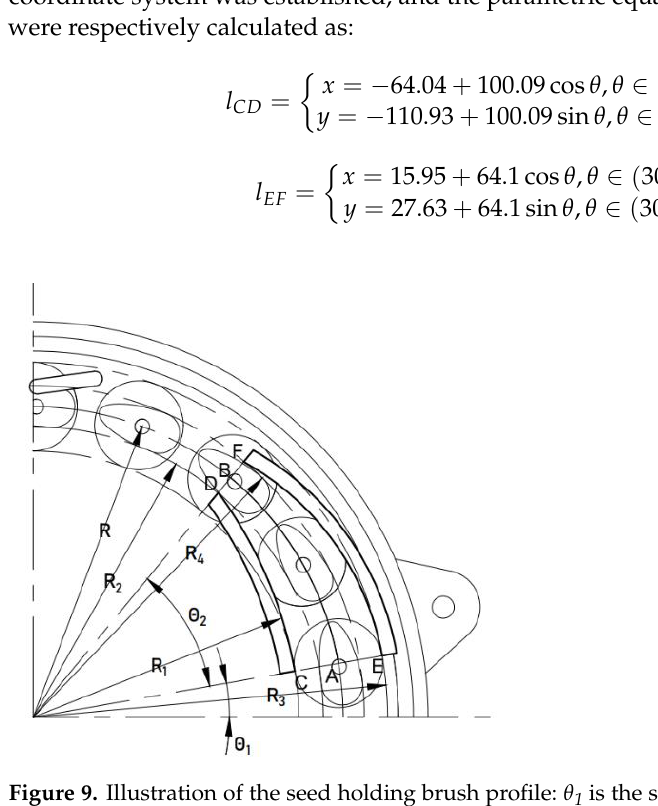
Figure 9. Illustration of the seed holding brush profile: θ 1 is the starting seed adjusting angle; θ 2 is the seed adjusting angle; R 1 is the starting circle radius of the lower seed adjusting brush; R 2 is the ending circle radius of the lower seed adjusting brush; R 3 is the starting circle radius of the upper seed adjusting brush; R 4 is the ending circle radius of the upper seed adjusting brush; A is the starting point of the seed-cleaning arc; B is the ending point of the seed adjusting arc; C is the starting point of the lower seed adjusting brush; D is the ending point of the lower seed adjusting brush; E is the starting point of the upper seed adjusting brush; and F is the ending point of the upper seed adjusting brush.